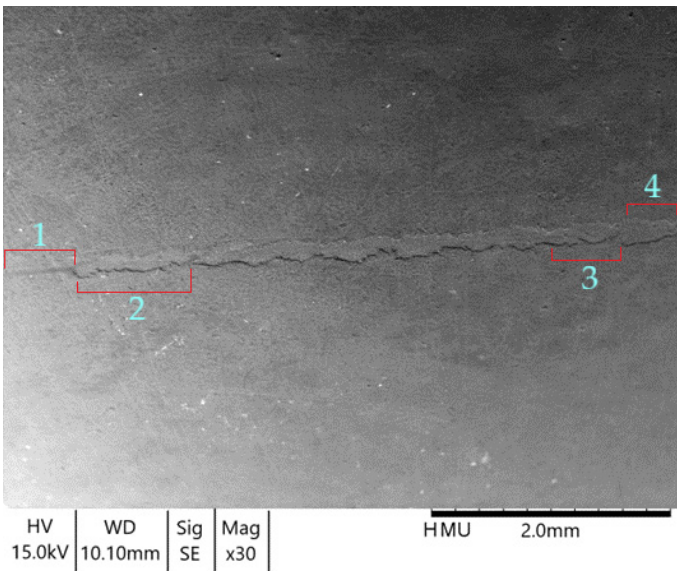
Figure 15. Coating A scratch positions 1, 2, 3 and 4 at ×30 Mag.